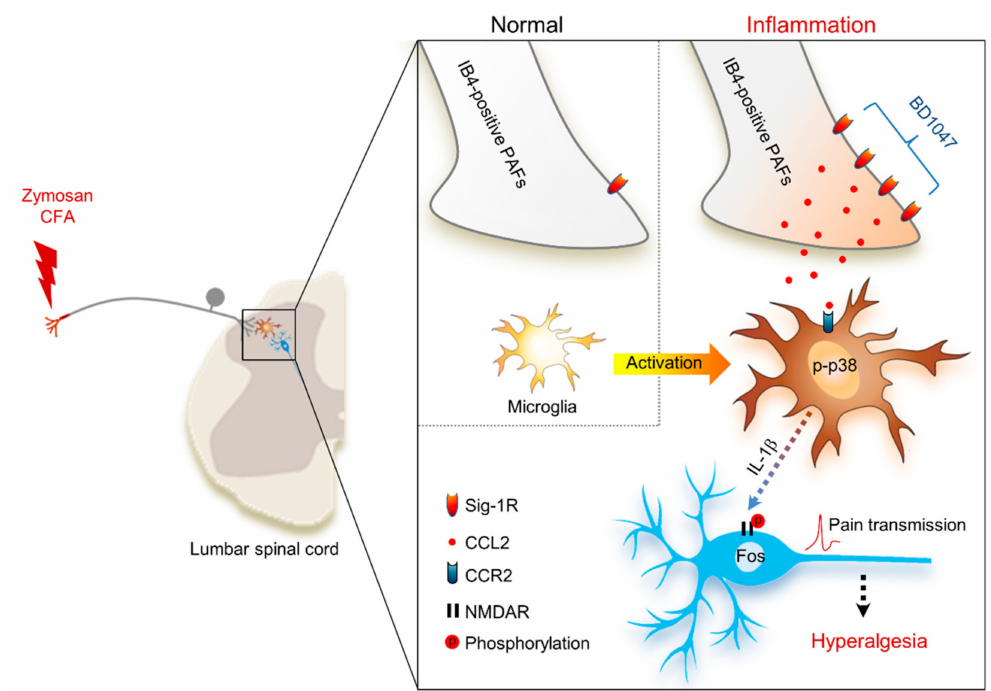
Figure 6. Schematic diagram proposing that the anti-nociceptive mechanism of sigma-1 receptor (Sig-1R) antagonist BD1047 for the inhibition of CCL2-induced microglia-neuron interactions in the spinal cord. Under inflammatory conditions, the presence of Sig-1R (a plausible binding site of BD1047) is especially increased in IB4-positive unmyelinated primary afferent fibers (PAFs). The activation of Sig-1R post-inflammation facilitates the elevation of CCL2 synthesis and release in unmyelinated PAFs. CCL2 binds to its plausible binding site (CCR2) in microglia, which elevates levels of phosphorylated p38 mitogen-activated protein kinase (p-p38) in microglia. CCL2-induced interleukin-1 β (IL-1 β ) release from the microglia ultimately increases the spinal neuronal activation (NMDA receptor (NMDAR) phosphorylation and Fos expression) associated with